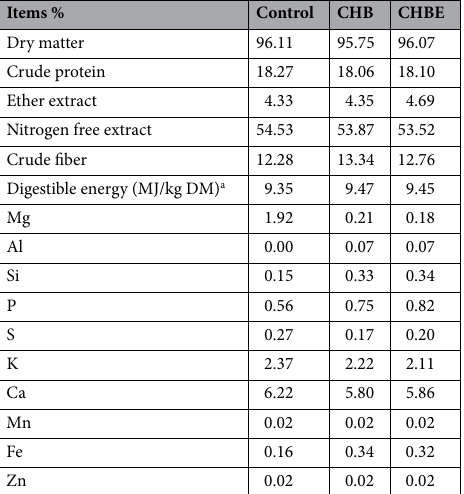
Table 2. Chemical analysis of the experimental diets. HB: hydroponic barley; CHB: Control diet substituted with 25% hydroponic barley; CHBE: Control diet substituted with 25% hydroponic barley with 0.5 g/kg enzymes. a DE estimated according to Fekete 19 .